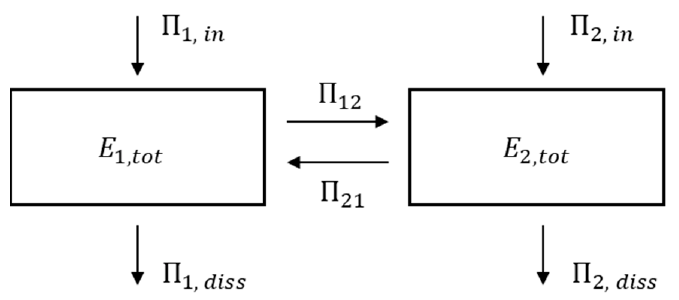
Figure 2. Power flow in two subsystems of SEA model.